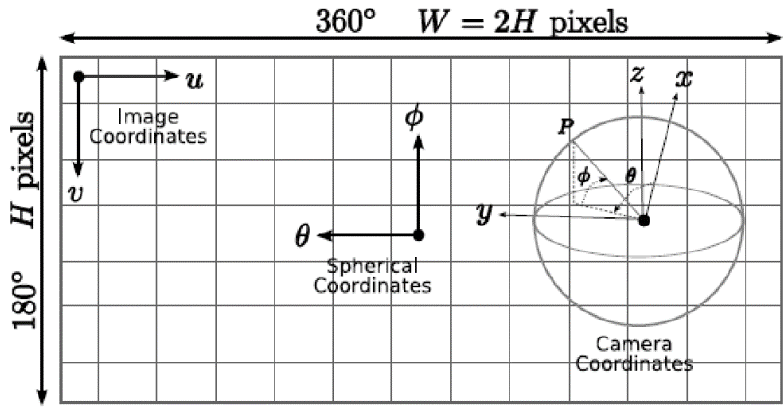
Figure 11. Spherical image and coordinate axes.